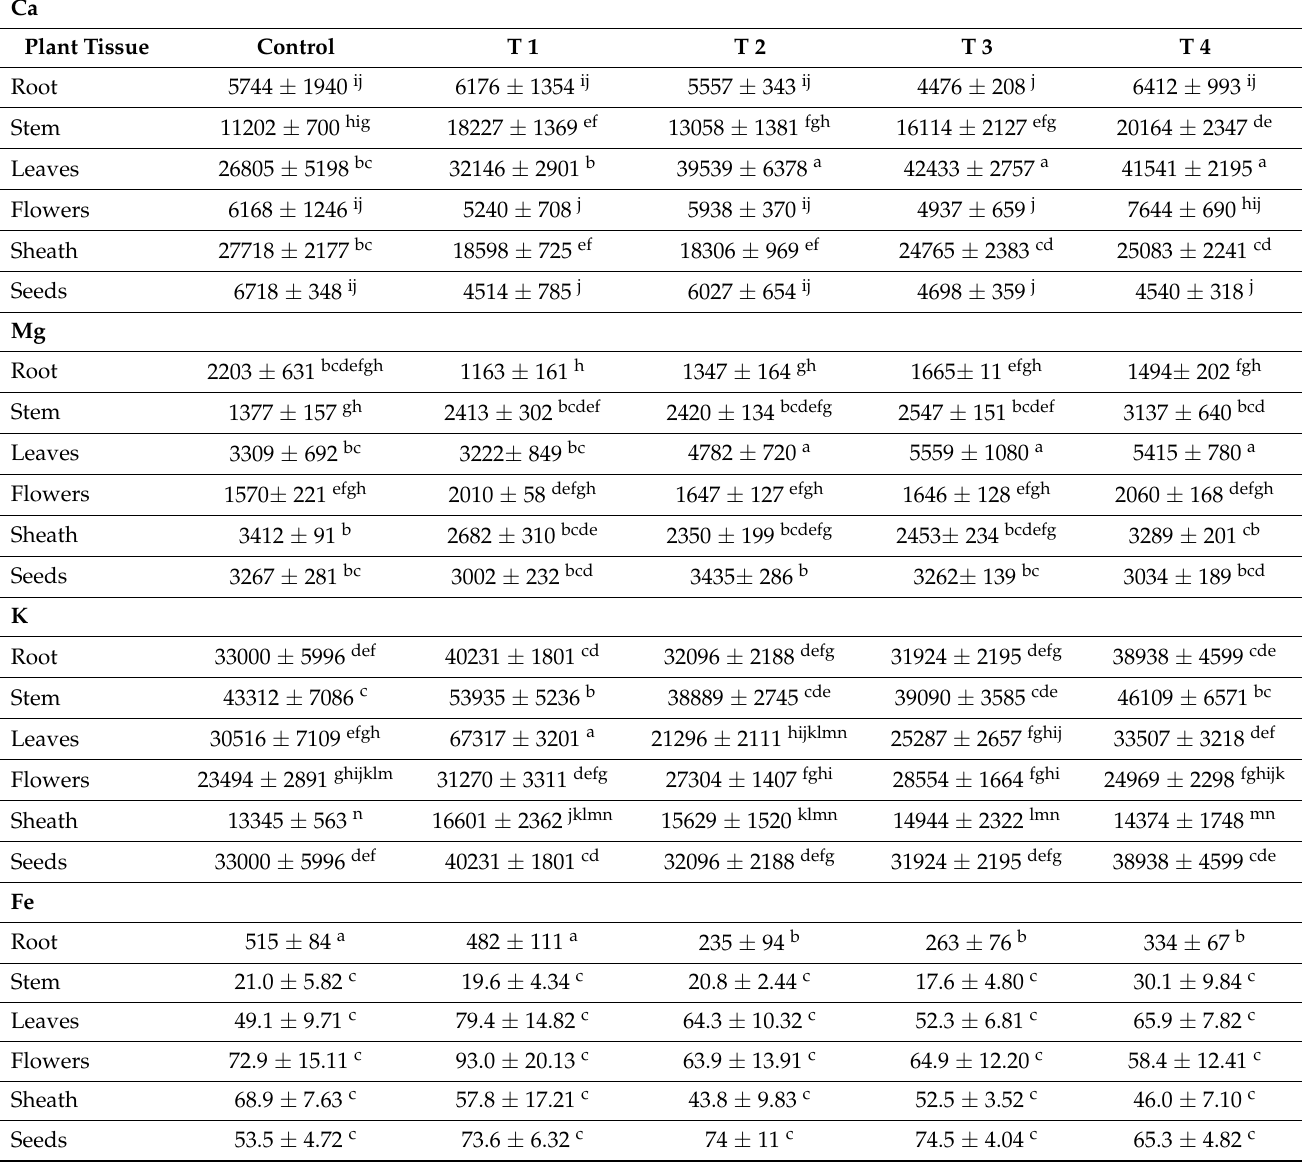
Table 8. Macro nutrients accumulation in plant tissues of S. alba (mean ± SD, n = 6), mg kg − 1